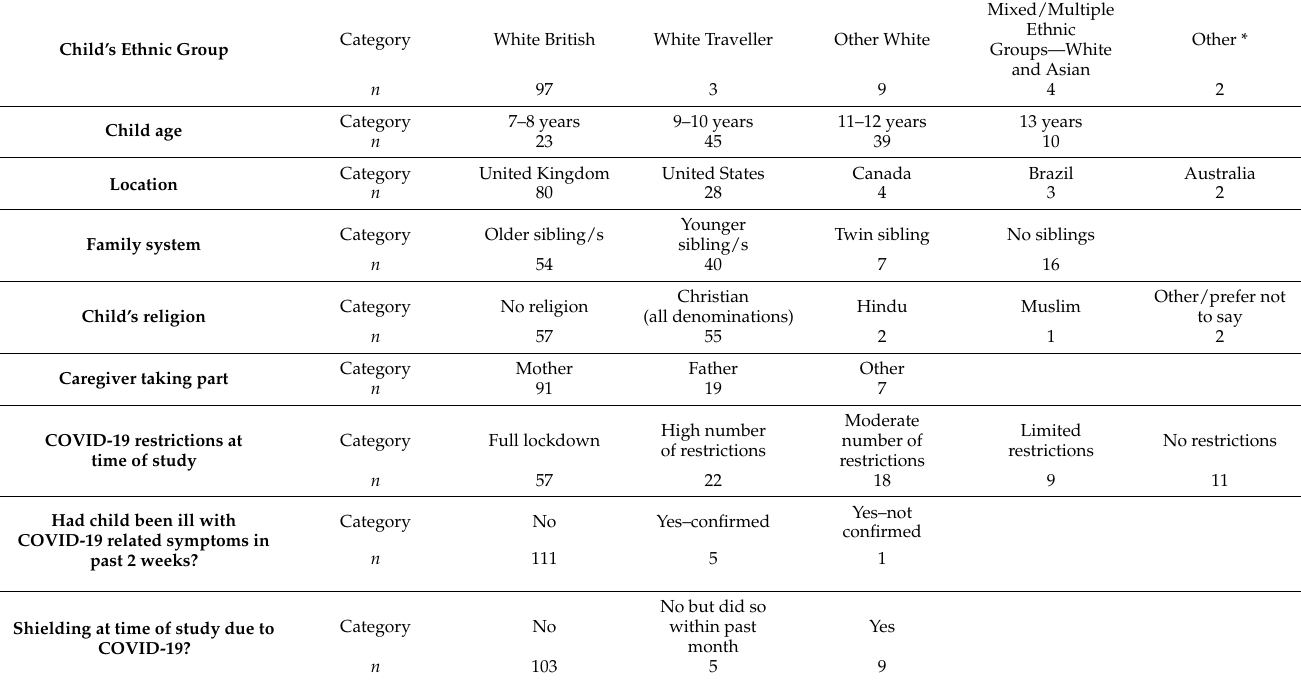
Table 1. Caregiver and child characteristics ( n ).